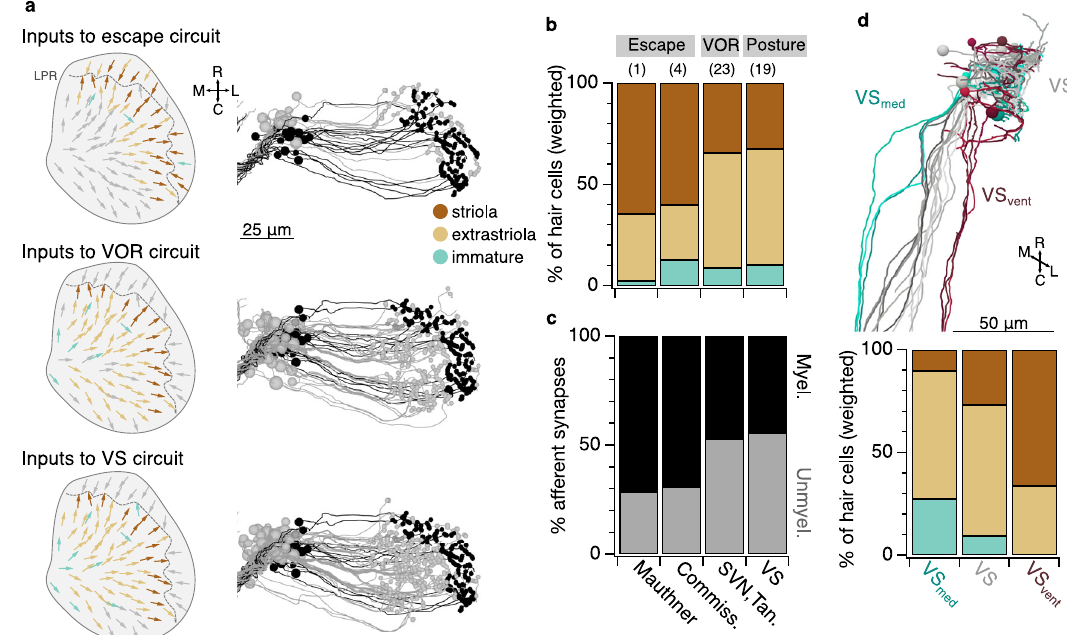
Fig. 6 | Early developing afferent pathways with fast kinetics preferentially drive early developing central neurons for fast escapes. a Hair cells in the utri- cular macula that excite afferents connected to Mauthner escape, VOR, or VS cir- cuits(top,middle,andbottom).Haircellsarecolorizediftheycontributeinputtoa pathway or gray if they do not. Right, afferents connected to escape, VOR, or VS circuits, colorized by their myelination status (black: myelinated; gray, unmyeli- nated). b Quanti fi cationof the contributionofstriolar, extrastriolar,and immature hair cells to these central pathways. Striolar hair cells preferentially drive rapid escapecircuits,bothviathedirectafferentinputtotheipsilateralMauthnerandthe afferent input to the commissural escape pathway, whereas VOR and VS circuits receive input from a mixture of pathways, with extrastriolar inputs dominating. Numbers in parentheses indicate the number of central neurons in each category. Wilcoxon test, striolar contribution to escape vs non-escape neurons, p